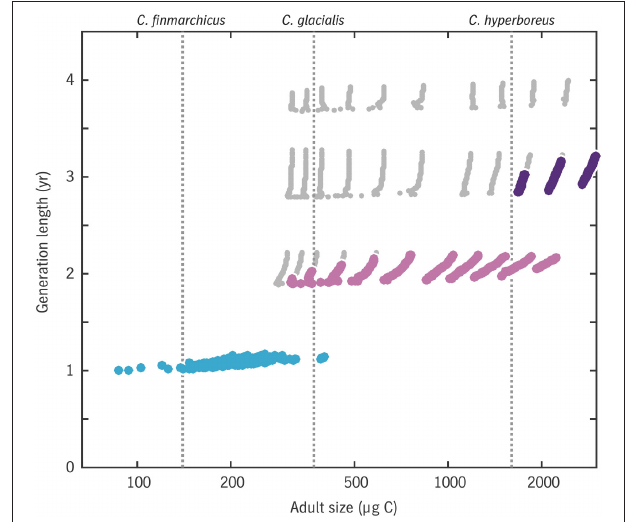
FIGURE 10 | Emergent relationship between generation length and adult size in the Disko Bay model experiment. Large colored dots indicate results for trait combinations that achieve a viable rate of egg production per generation (color coding matches that in Figure 12 : blue, generation length of 1 year; light purple, 2 years; dark purple, 3 years) while small gray dots indicate trait combinations that reach maturity without starvation but have egg production rates below replacement